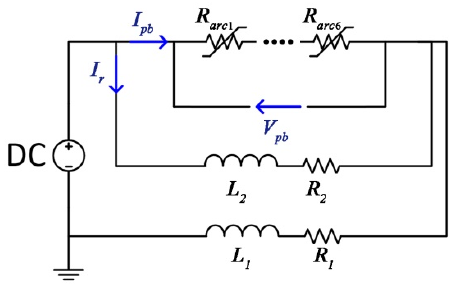
Figure 5. Commutation test at 40 kA: ( a ) Current oscillogram, ( b ) Voltage oscillogram.